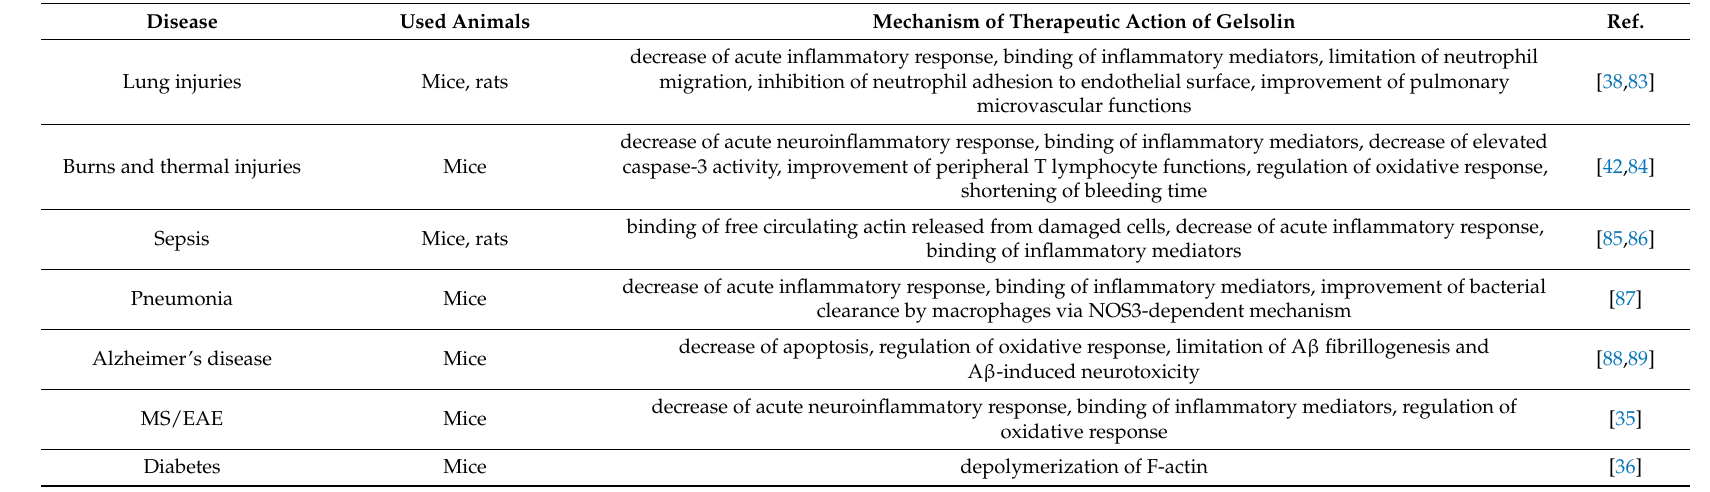
Table 2. Effects of animal studies aiming to evaluate the therapeutic potential of exogenous recombinant